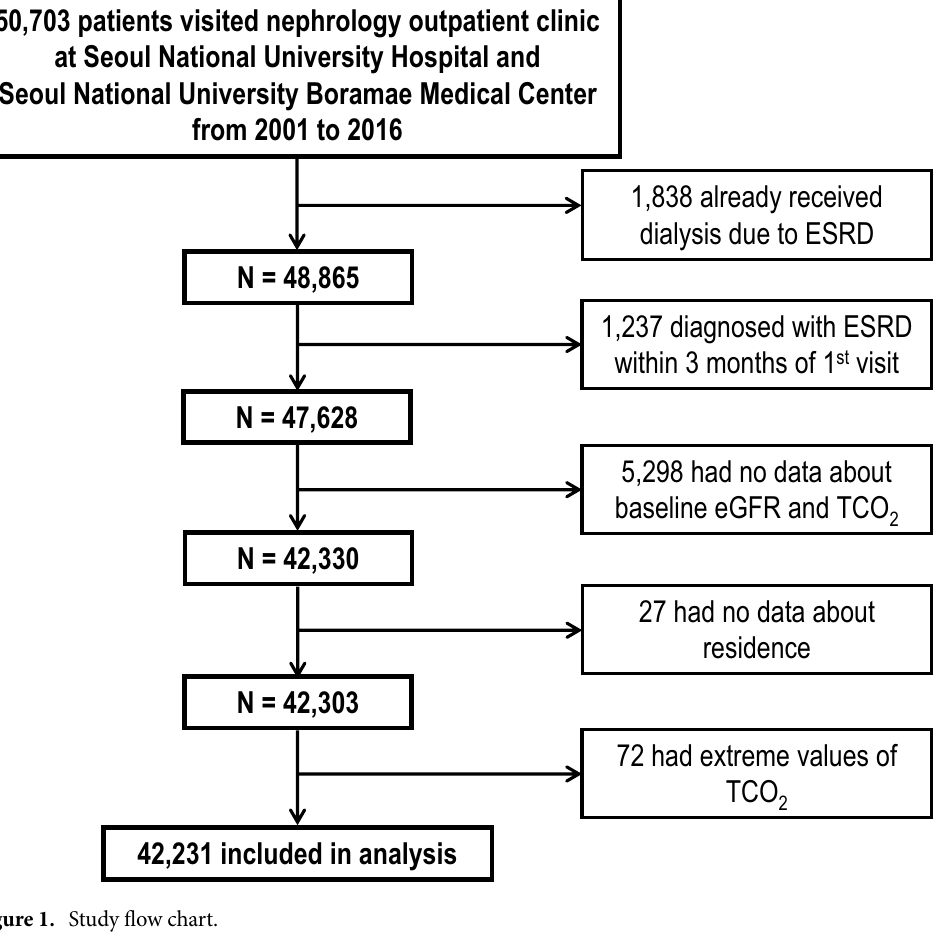
Figure 1. Study flow